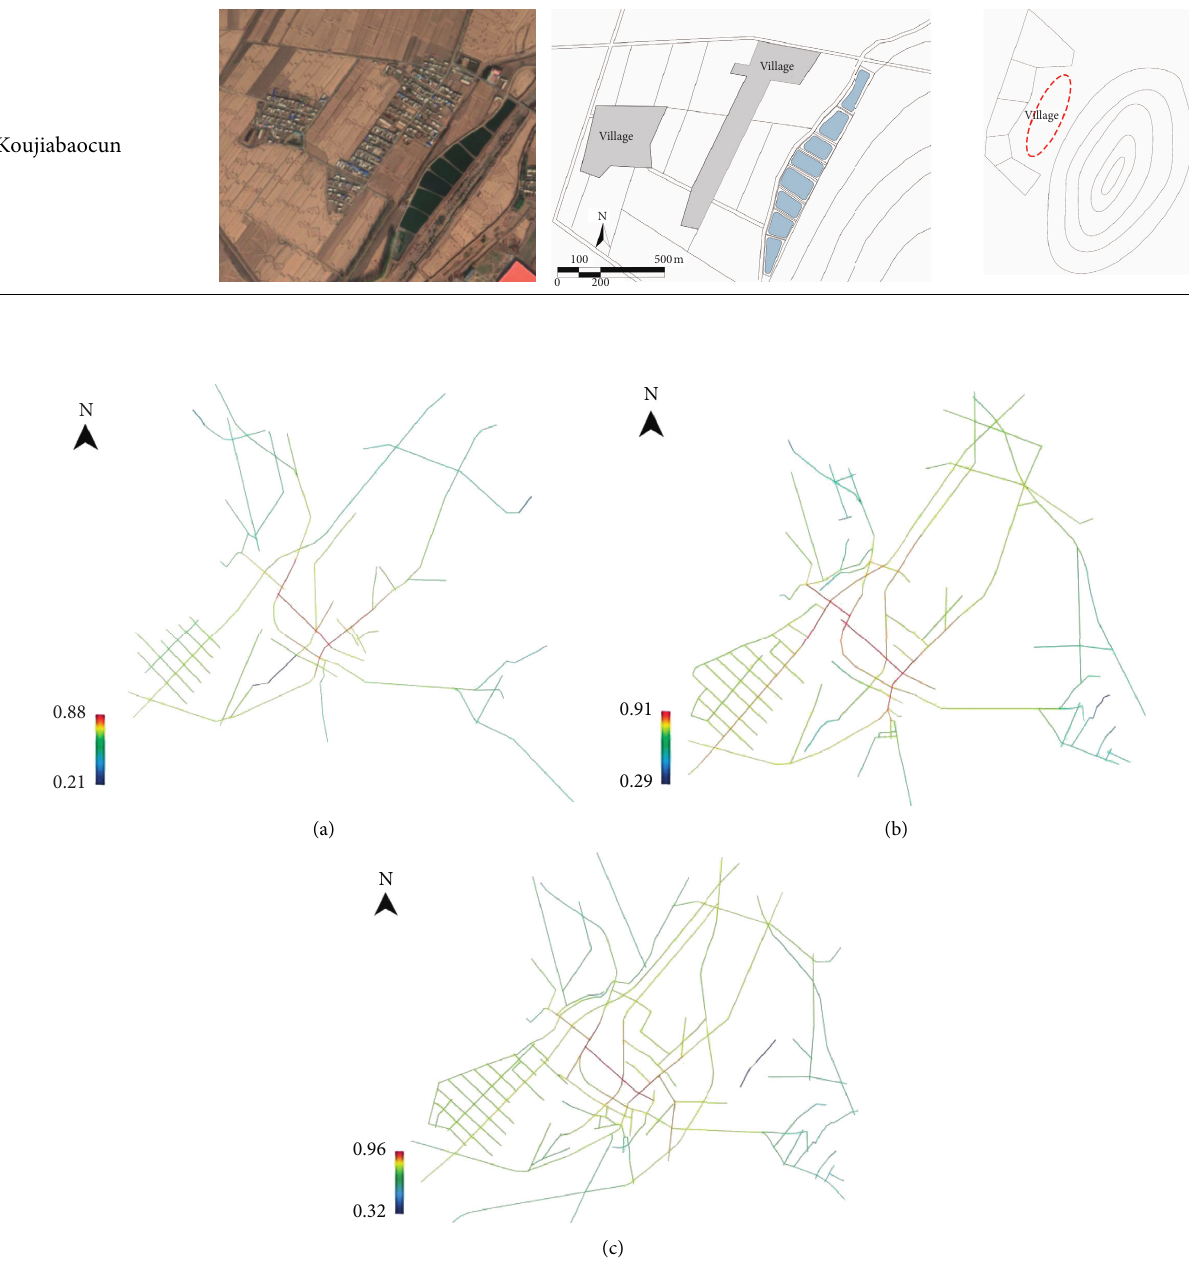
Figure 4: Global integration axis. (a) 2009. (b) 2014. (c) 2019. Table 8: Factors and indicators of spatial and temporal land-use evolution in Ciyutuo